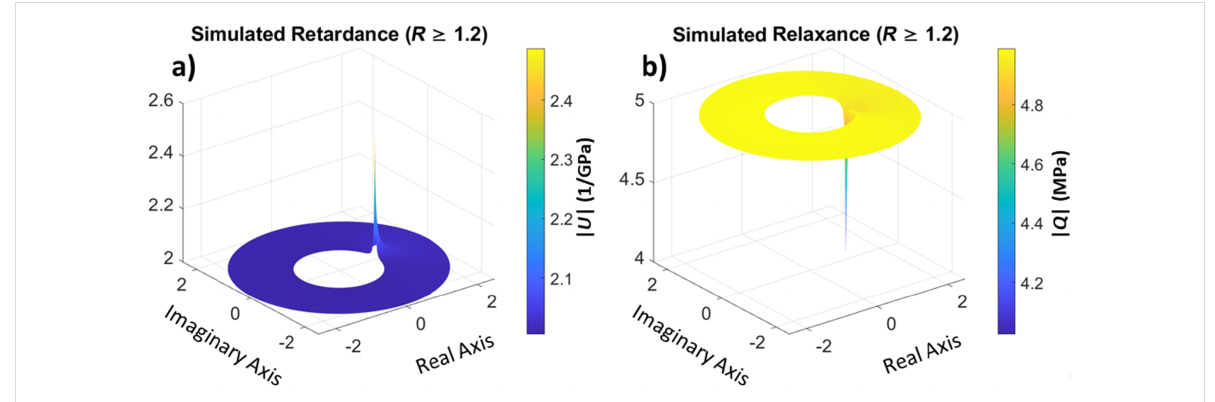
Figure 5: (a) Retardance and (b) relaxance for our simulated material. The retardance is the same as depicted in Figure 4 and the relaxance is directly calculated as its reciprocal.